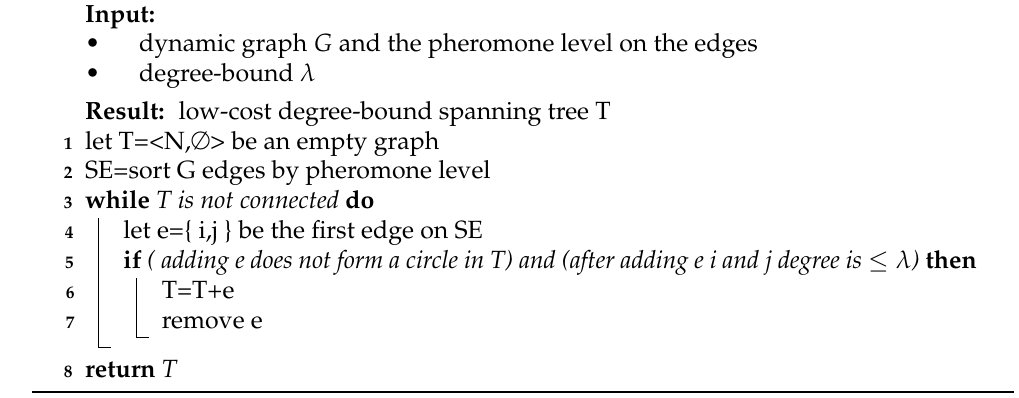
Algorithm 4: Tree construction